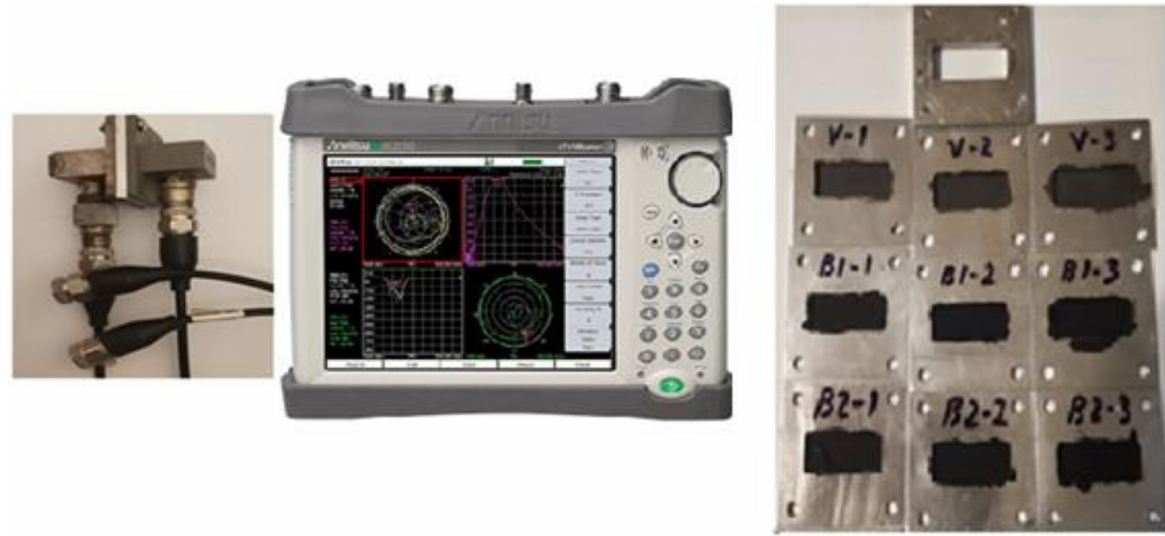
Figure 1. The measuring setup for EMI-shielding efficiency based on the ANRITSU Vector Network